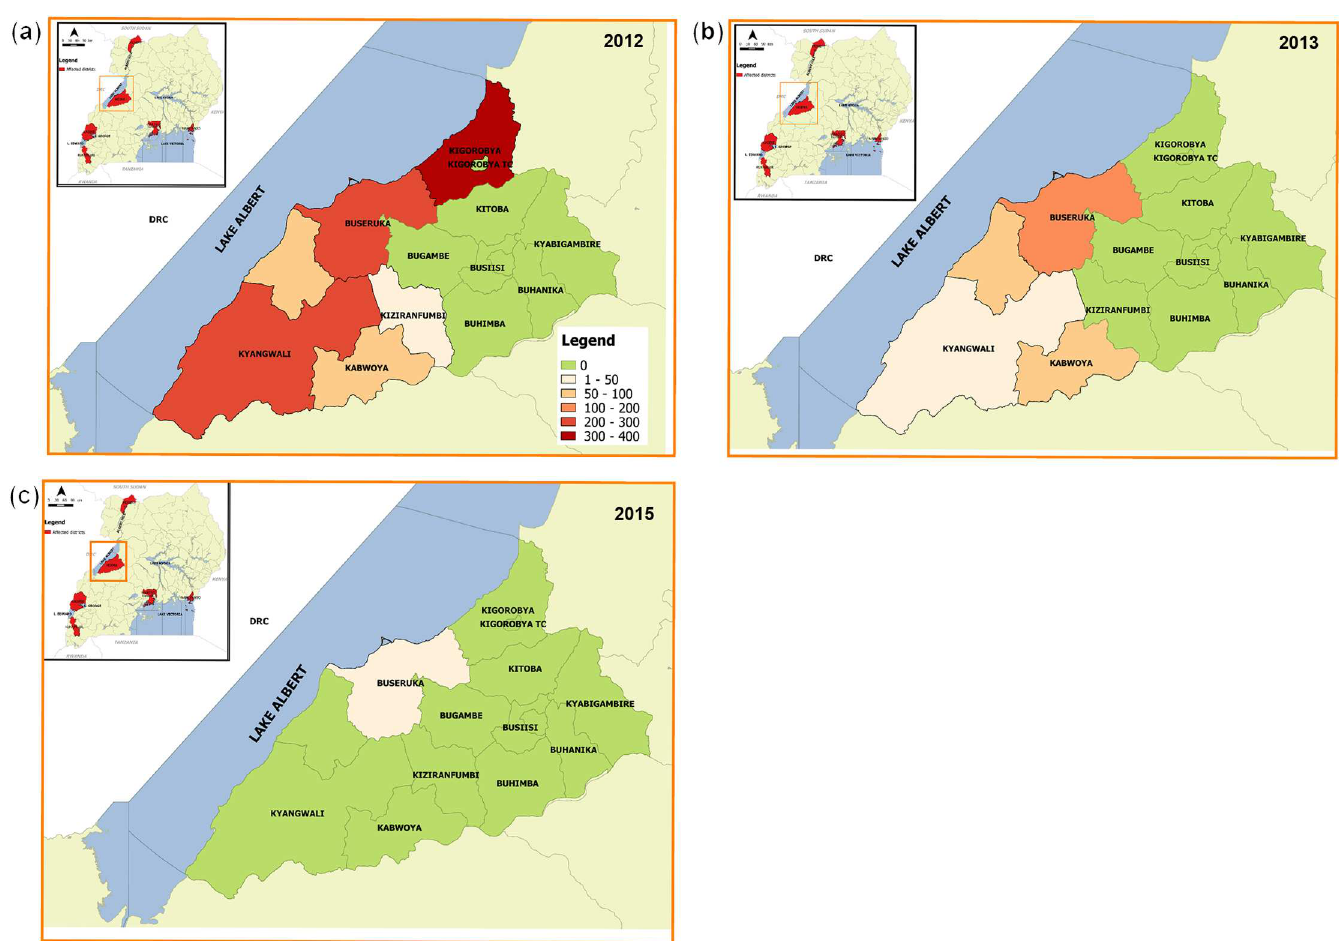
Fig 4. Cholera outbreaks that occurred in fishing villages along Lake Albert. Fig 4a-4c: Choleraoutbreaks in Hoima district in 2012, 2013and 2015, respectively.